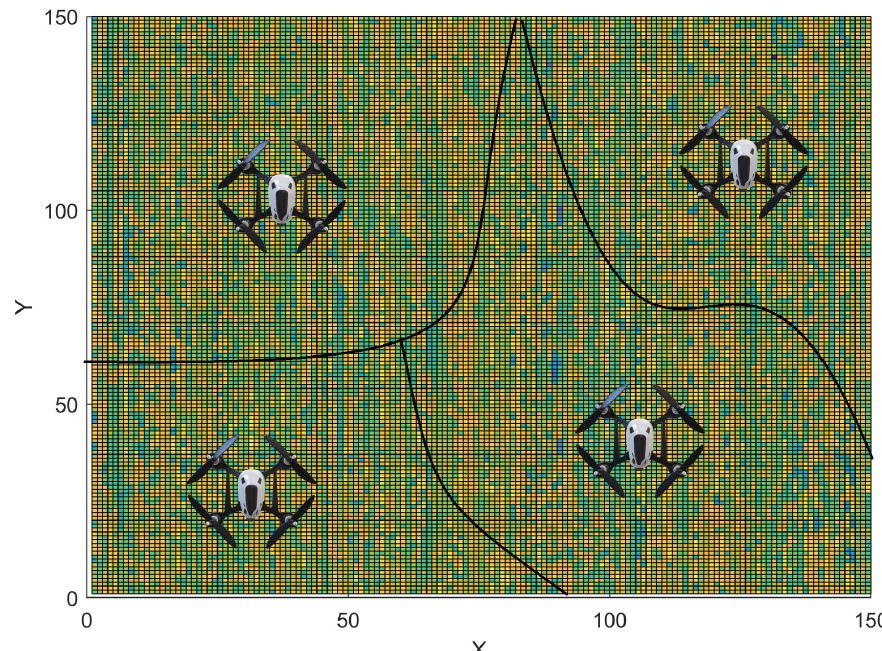
Figure 11. An illustration of multi-robot information collection. The environment is divided into four sub-regions and the underlying heatmap represents measures of soil acidity in parts of the USA